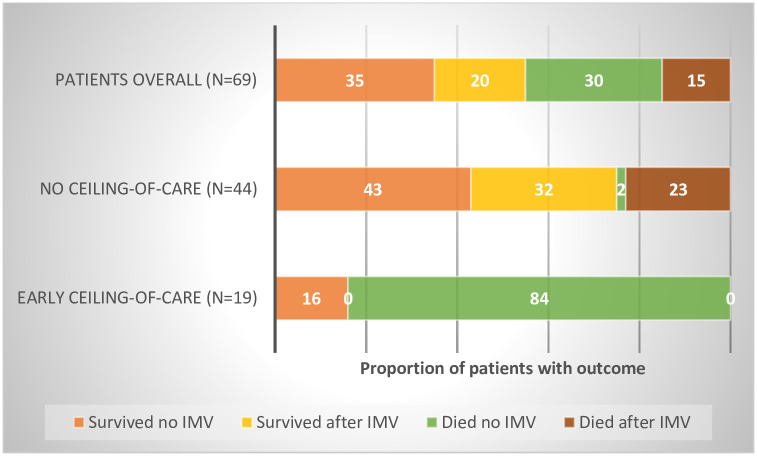
Outcomes among all patients who ever received CPAP, by ceiling-of-care status (numbered version).